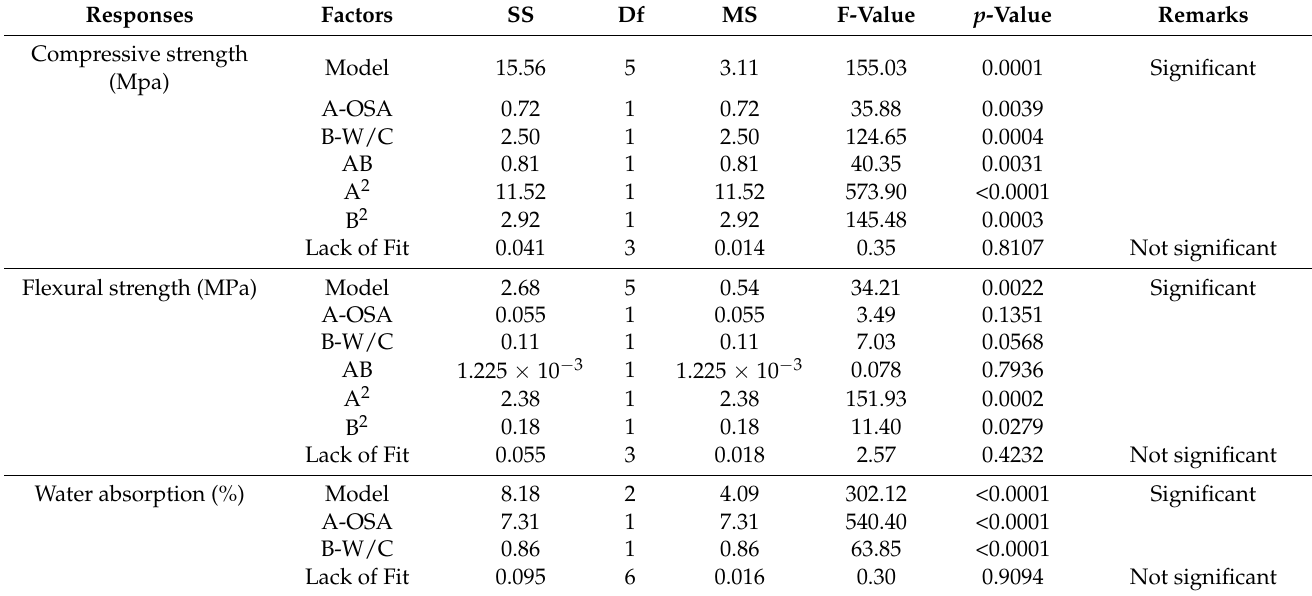
Table 6. Analysis of variance for response